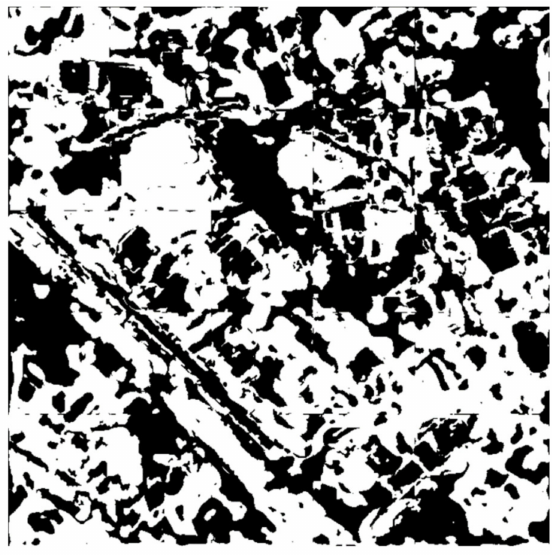
Figure 17. Prediction